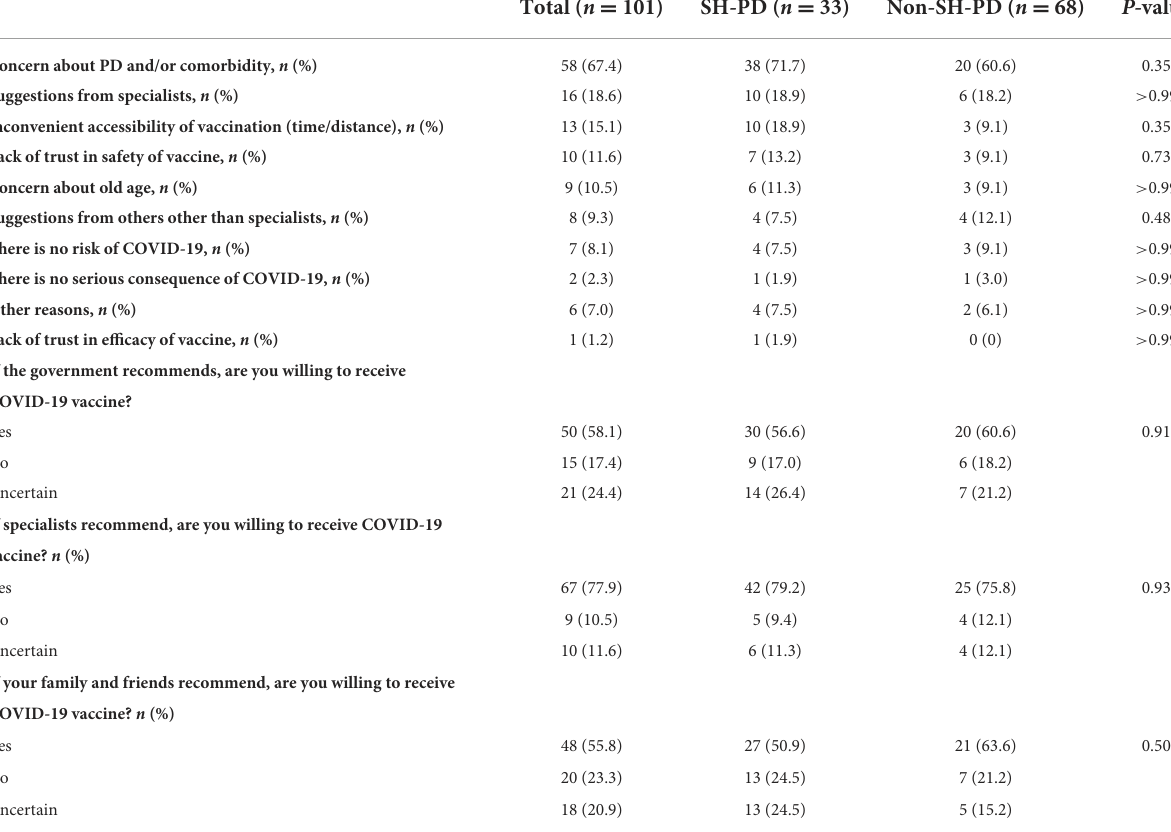
TABLE 4 Reasons for vaccine